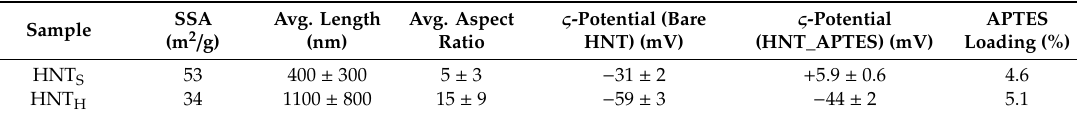
Table 1. Physicochemical properties of bare and functionalized HNT: specific surface area (SSA), average length and aspect ratio, ς -potential at spontaneous pH, and APTES loading from TGA.